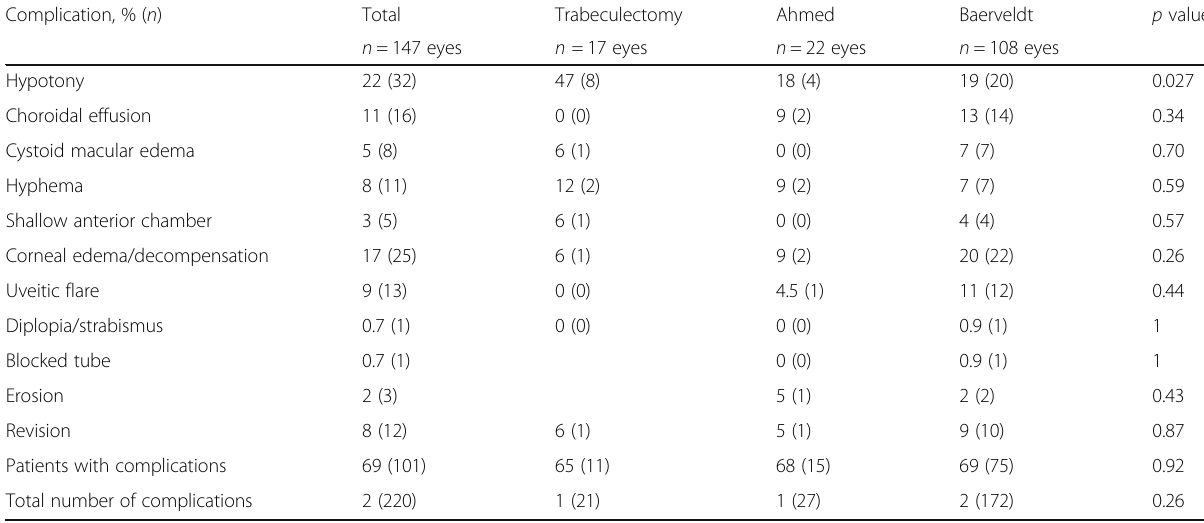
Table 4 Early postoperative